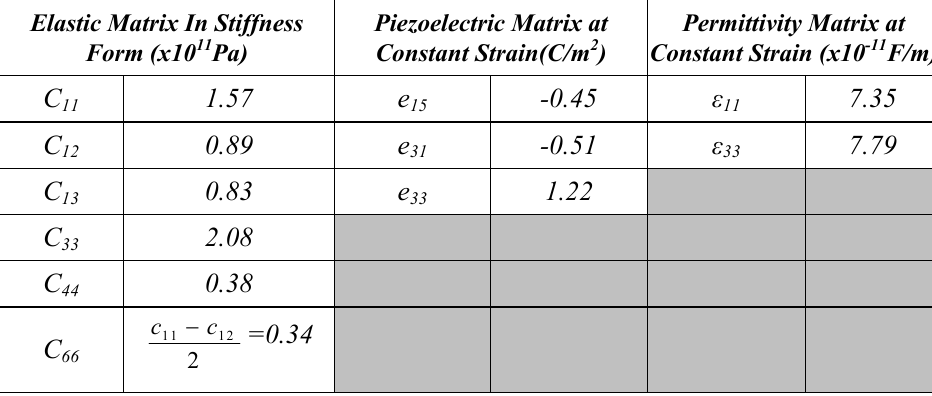
Table 2. Material Properties for zinc